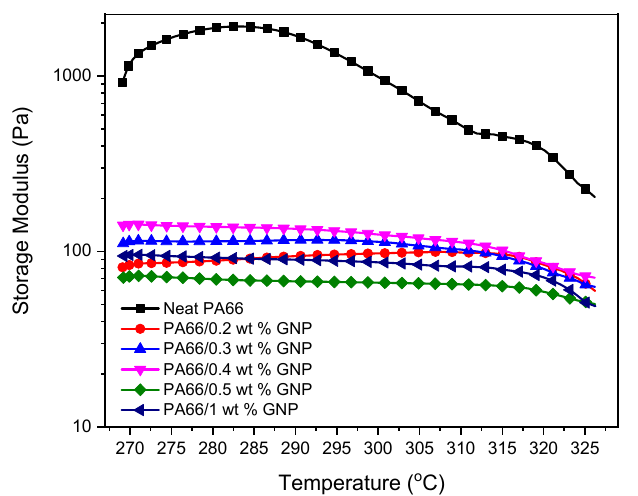
Figure 6. Storage Moduli of neat PA66 and PA66 GNP composites as a function of temperature.